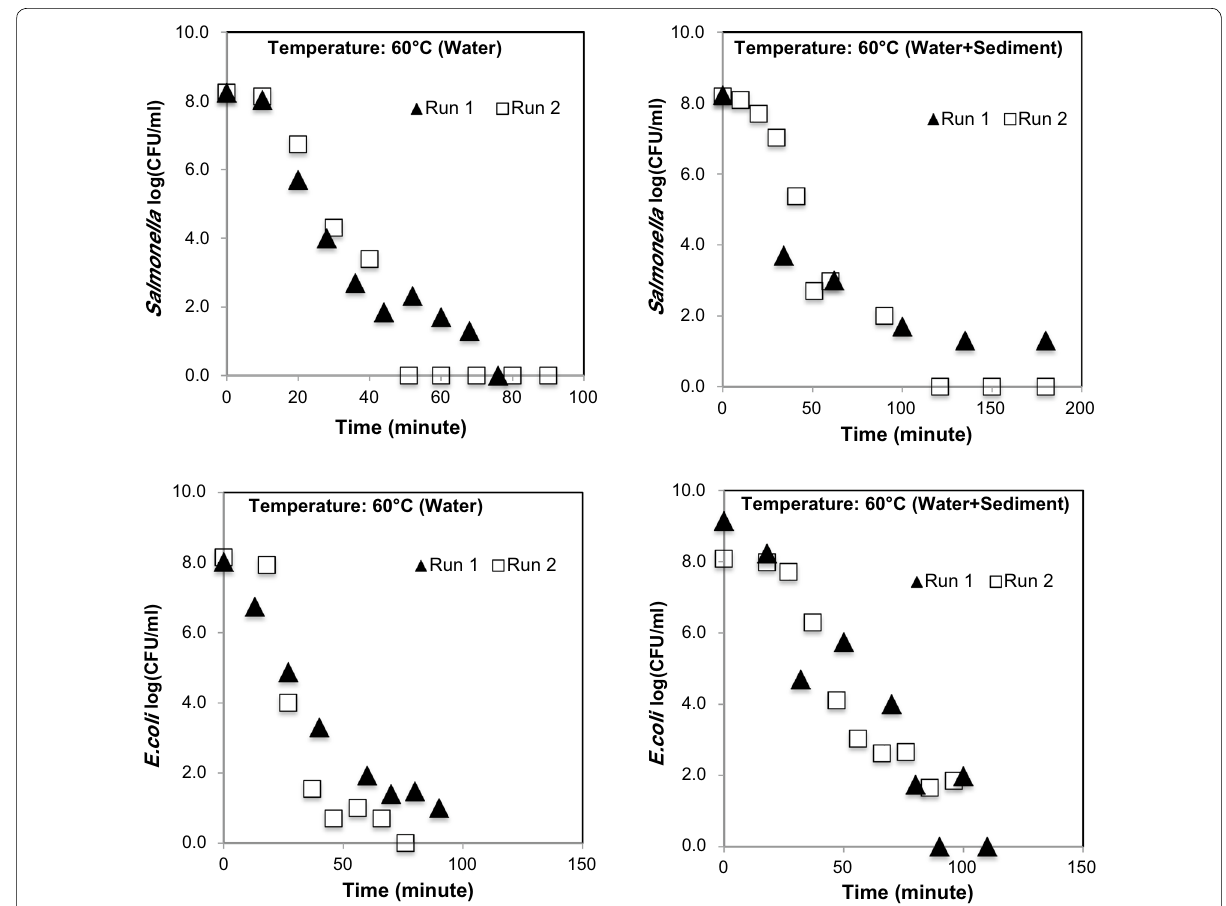
Fig. 6 Survival of Salmonella and E. coli O157:H7 and at 60 °C (thermophilic temperature) in free floating and particle attached